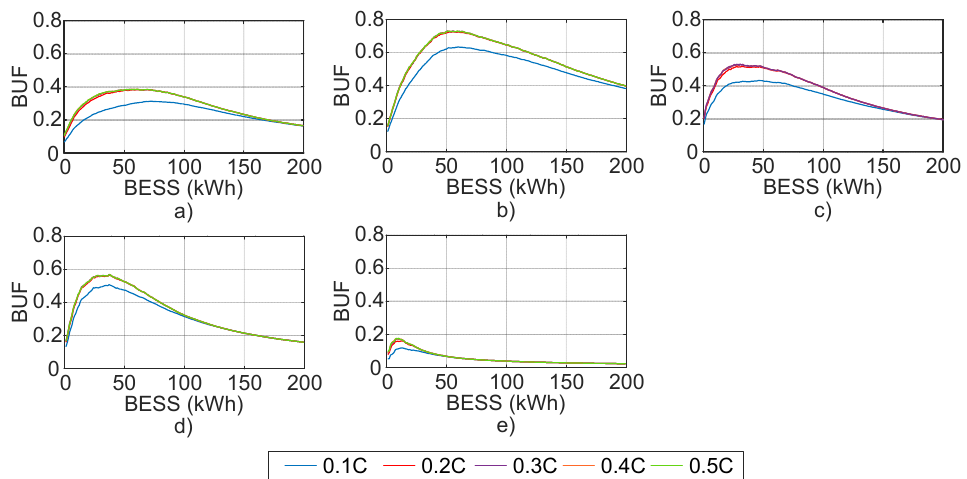
Figure 8. Battery Utilization Factor for BESS systems rated from 1 kWh to 200 kWh at charging rates of 0.1C up to 0.5C. ( a ) BUF for EC 1. ( b ) BUF for EC 2. ( c ) BUF for EC 3. ( d ) BUF for EC 4. ( e ) BUF for EC 5.